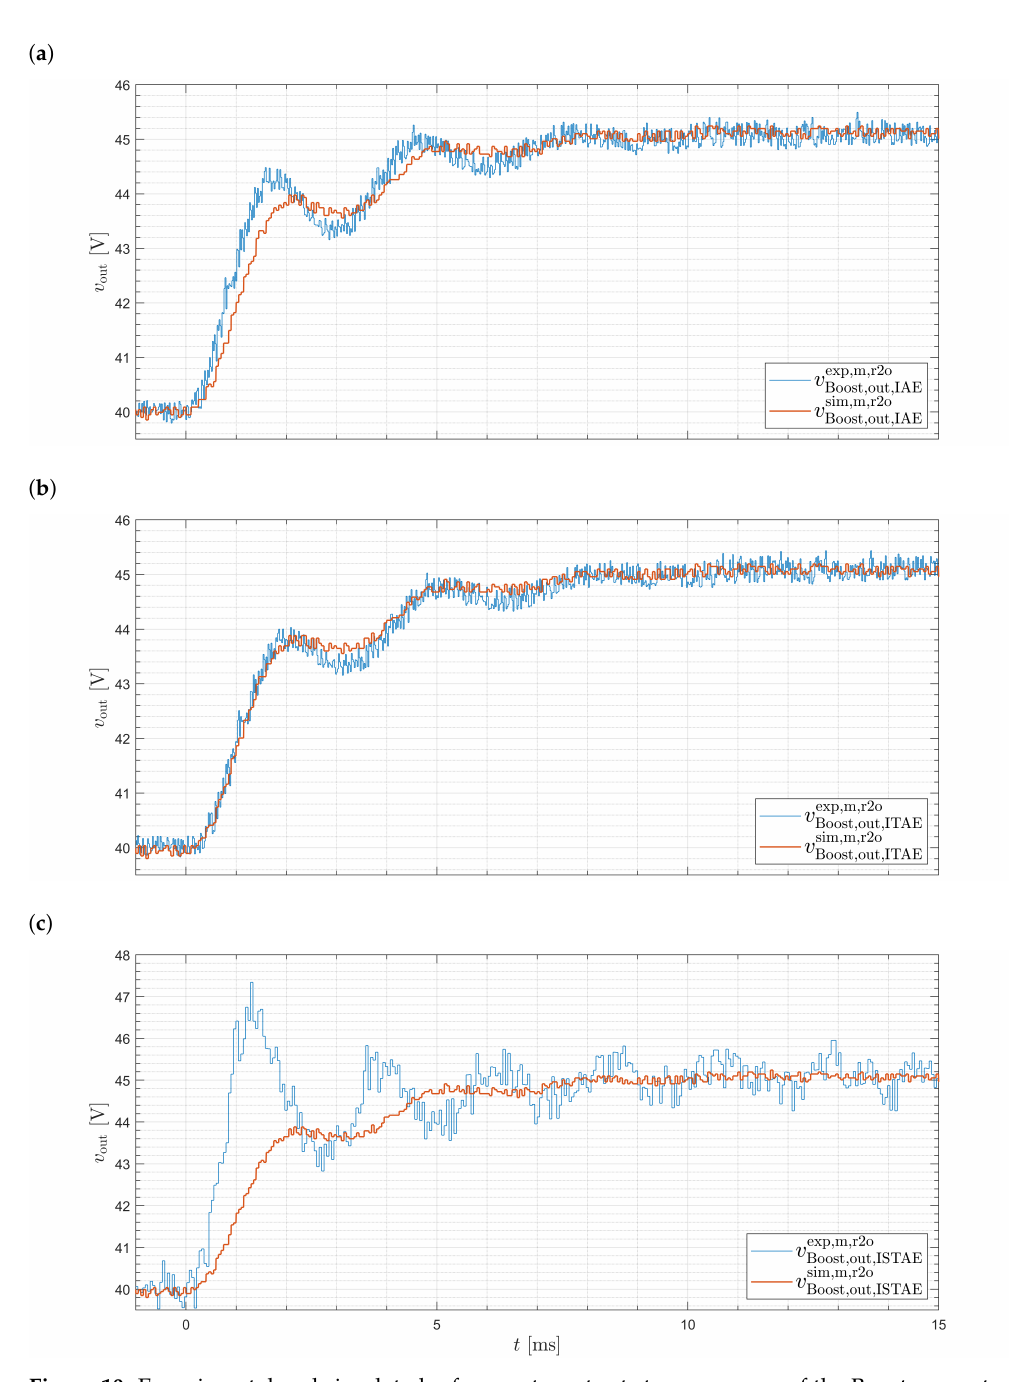
Figure 10. Experimental and simulated reference-to-output step responses of the Boost converter output voltage, v exp,m,r2o and v sim,m,r2o respectively, for different K P and K I compensator gains, Boost,out,.. Boost,out,.. see Table 4. The gains have been selected by means of global stability constrained GA basing on three different fitness functions: ( a ) IAE according to Equation (26); ( b ) ITAE according to Equation (27); ( c ) ISTAE according to Equation